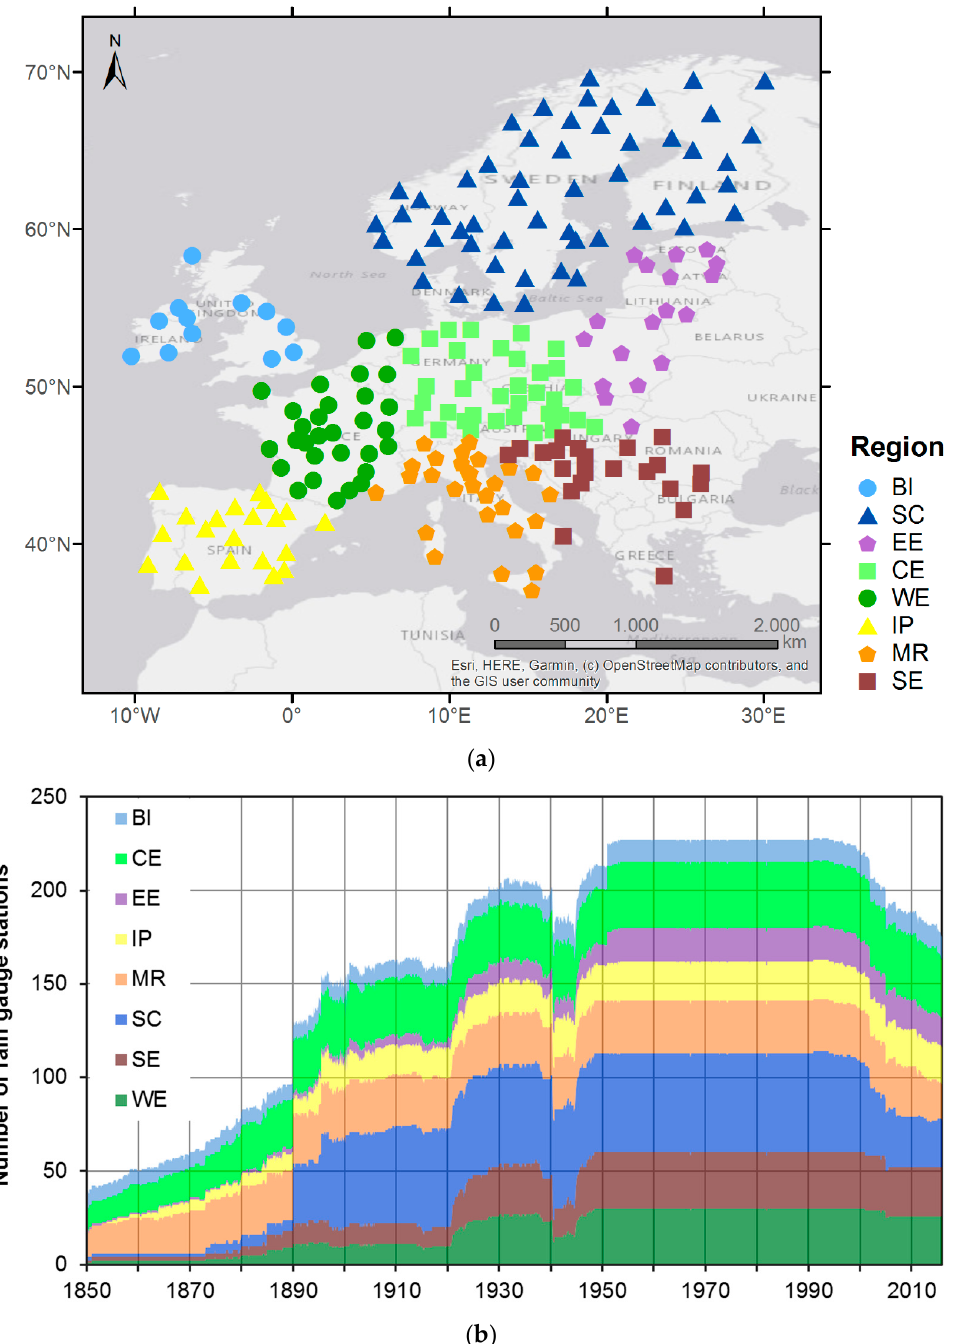
Figure 1. ( a ) Location of the 220 rain gauge stations and ( b ) number of stations with digitally available monthly precipitation time series between 1851 and 2015. The stations are grouped into eight regions (BI: British Isles, CE: Central Europe, EE: Eastern Europe, IP: Iberian Peninsula, MR: Mediterranean Region, SC: Scandinavia, SE: South Eastern Europe, WE: Western Europe).